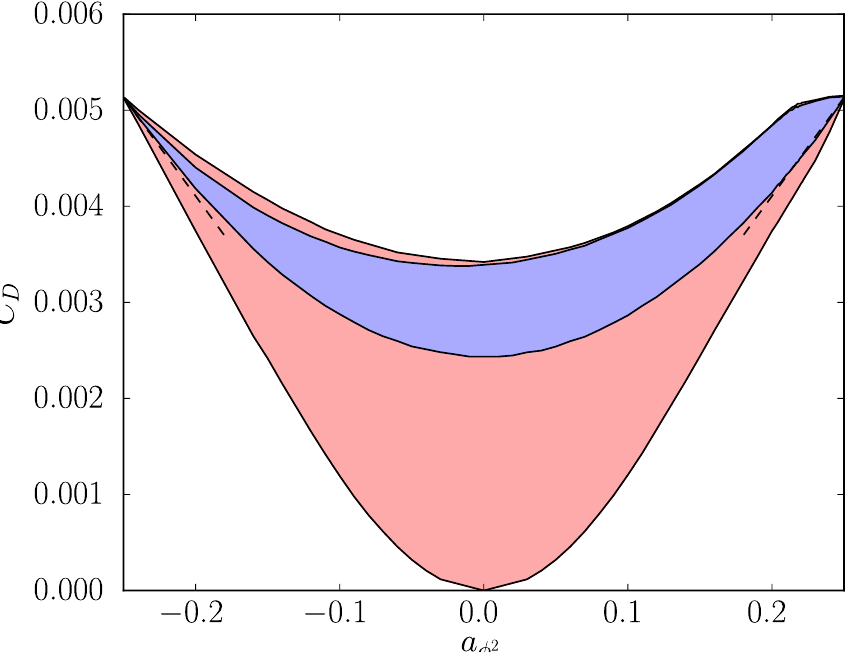
Figure 4. An asymmetric plot showing the minimum and maximum C D as a function of a the blue region, all dimension 4 scalars not singled out by (5.13) are constrained to satisfy b No such constraint is made in the pink region which leads to weaker bounds. The dotted lines give the predictions of conformal perturbation theory which are model-independent at leading order. A slight kink in the upper right corner looks well positioned to be identified with the kink in figure